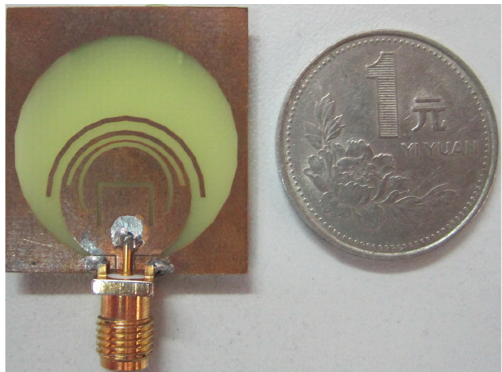
Figure 4: Photograph of the proposed quadruple band-notched UWB antenna.